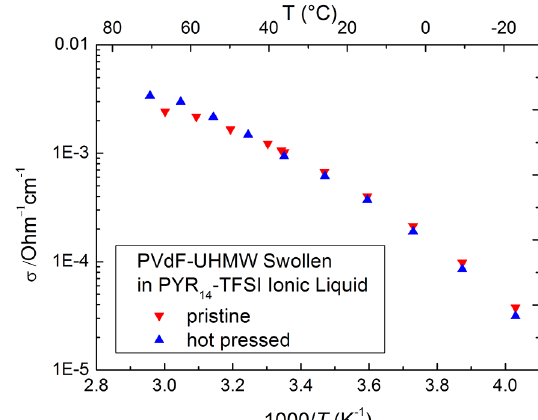
Figure 6. Temperature dependence of the conductivity of both unpressed and hot pressed membranes swelled with PYR ionic